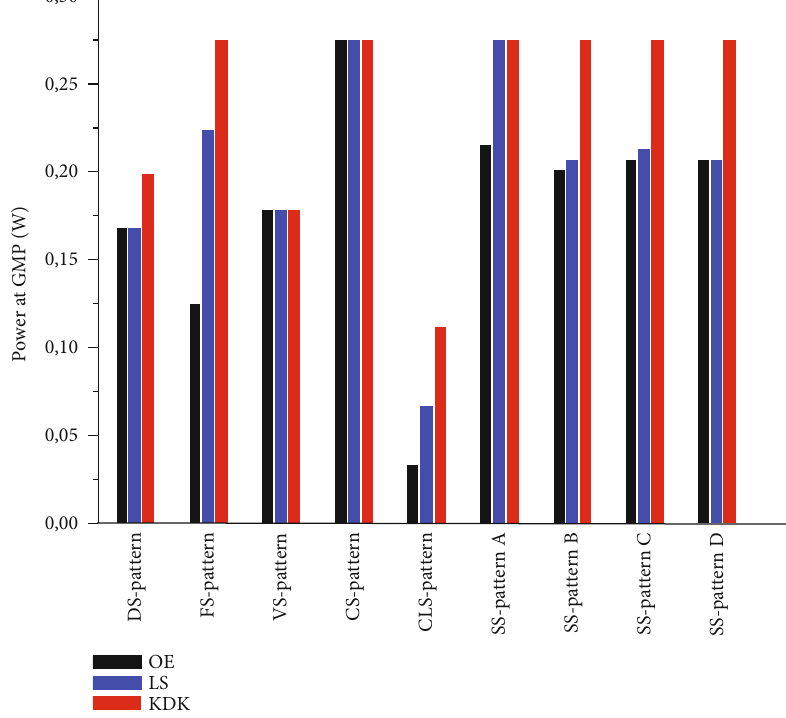
Figure 18: E ff ects of partial shading patterns on power (at MPP).